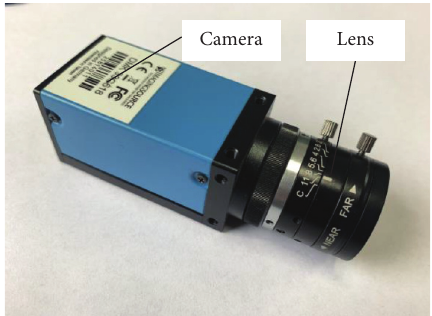
Figure 3: Camera and lens.